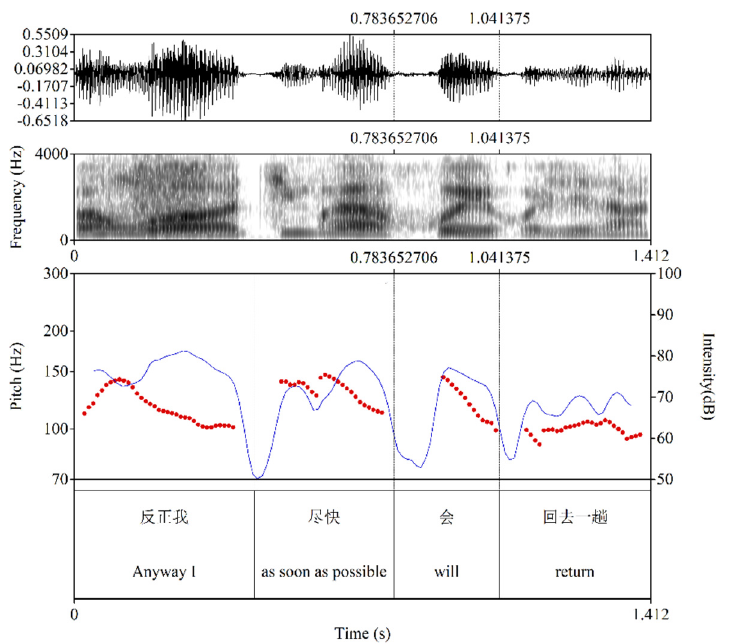
Figure 2. Waveform, spectrogram, pitch contour, and intensity of line 01 in Ex 13. A comparison of pitch range, duration, and mean intensity of the two tokens of huì in Ex 12 and Ex 13, and the values of these indicators of the surrounding falling syllables are shown in Table 1. In Ex 13, huì is produced with a noticeable expended pitch range and longer duration, compared to the proceeding syllable kuài . In contrast, huì in Ex 12 is pro‑ duced with reduced pitch range, duration, and mean intensity compared to the succeeding falling syllable guò Table 1. Duration, mean intensity, and pitch range of huì in Ex 12 and Ex 13 .